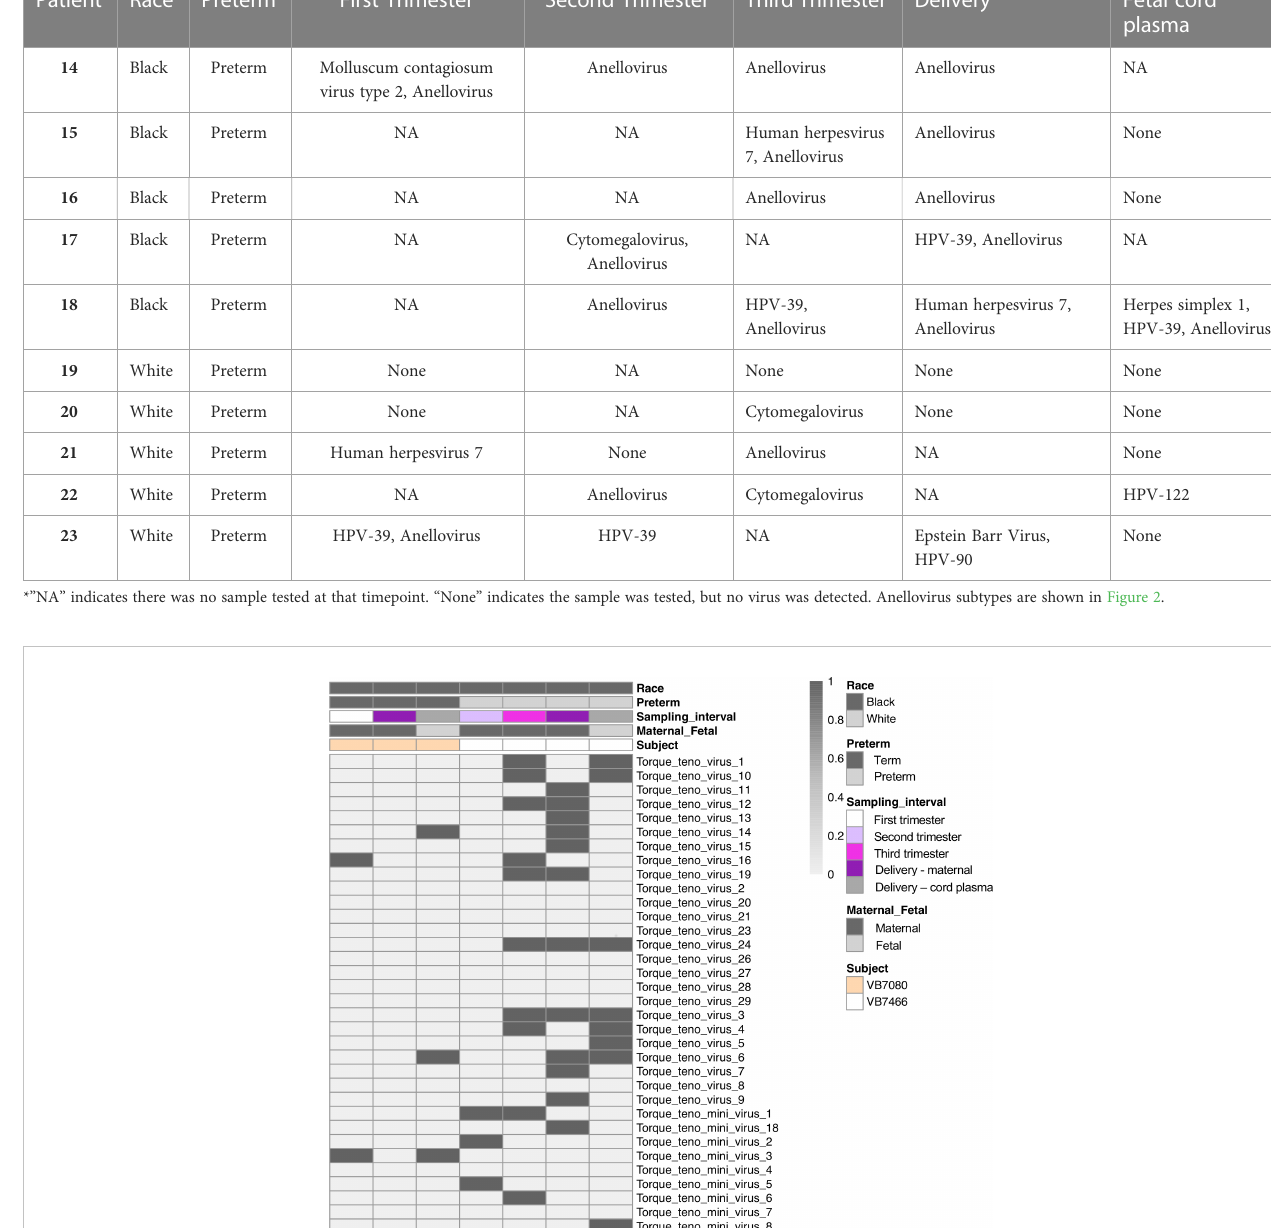
of Alphatorquevirus (including torque teno virus types 1, 3, 4, 6, 10, and 24) , Betatorquevirus (including torque teno mini virus 8), and Gammatorquevirus (including an unclassi fi ed torque teno midi virus type). That maternal subject was positive for a mixture of anelloviruses from the second trimester onward, including at delivery. No fi rst trimester sample was available. While the torque teno virus 5 and torque teno midi virus 8 were only detected in the